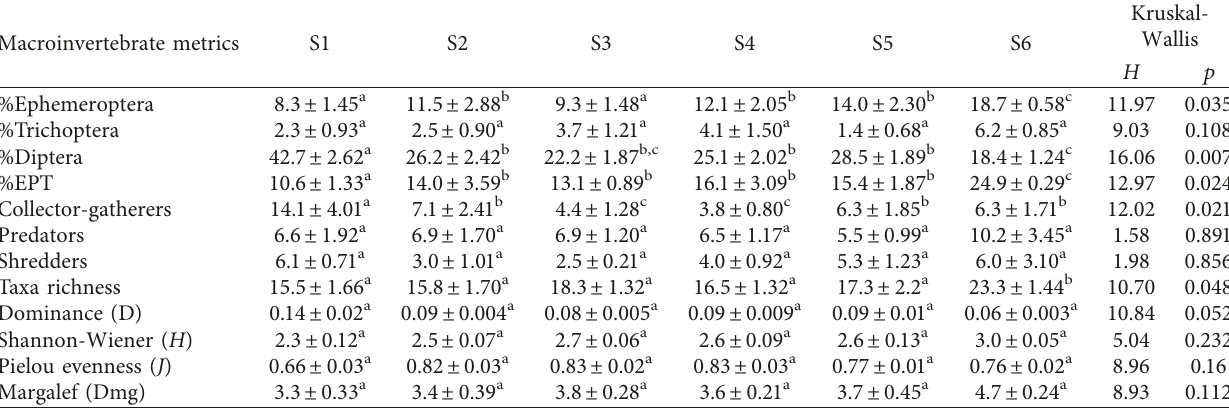
Table 5: Mean ( ± SE) of macroinvertebrate metrics calculated for six sites in Sanyati basin, Lake Kariba, for the period January-March 2018.